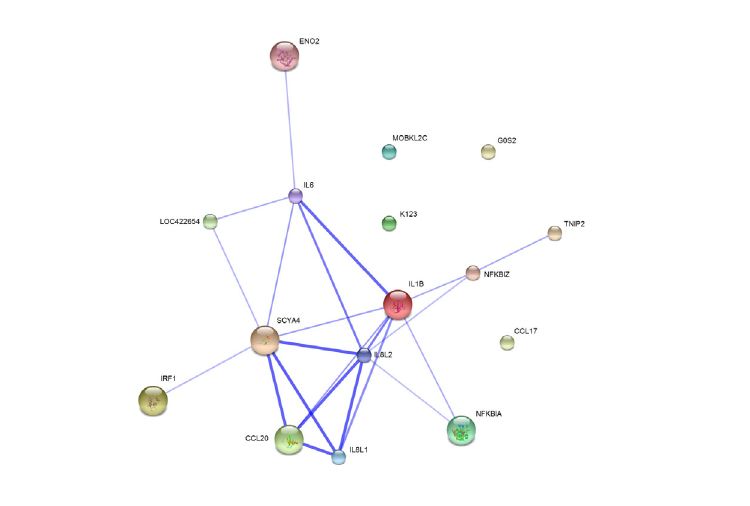
Fig 2. Interaction analysis of genes inducible in CEFs infected with S . Enteritidis. Figure presents a confidence view of protein interactions in chicken ( Gallus gallus ) generated by the STRING Database v9.1 for genes significantly upregulated more than threefold in CEFs in response to both Salmonella strains. Lines represent associations based on experimental data, co-expression, databases and/or homology.